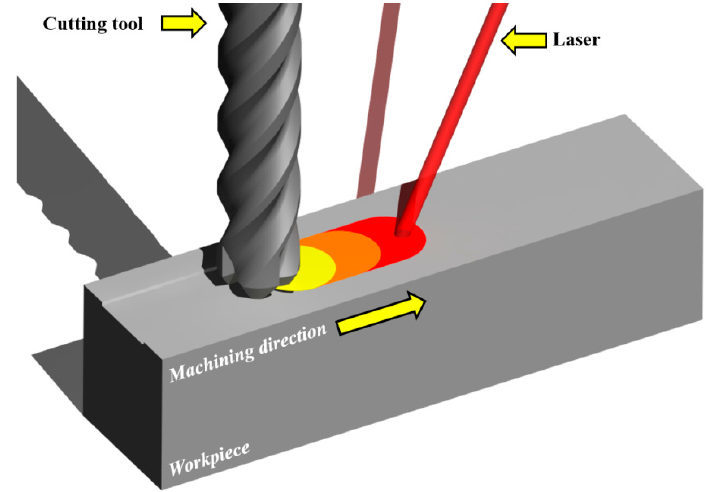
Figure 1. The schematic diagram of laser-assisted machining (LAM).